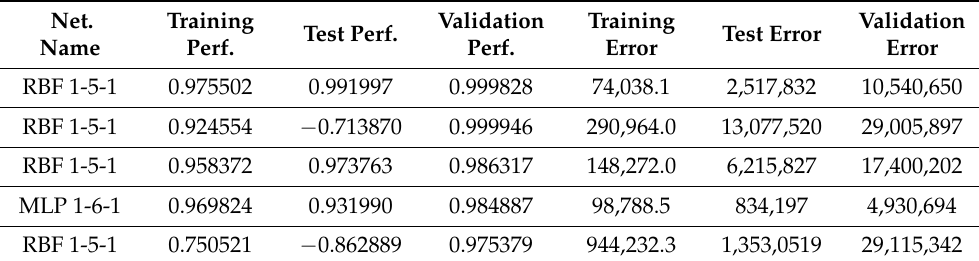
Table 5. Alternative univariate models for predicting Y mining gross value added. Net.